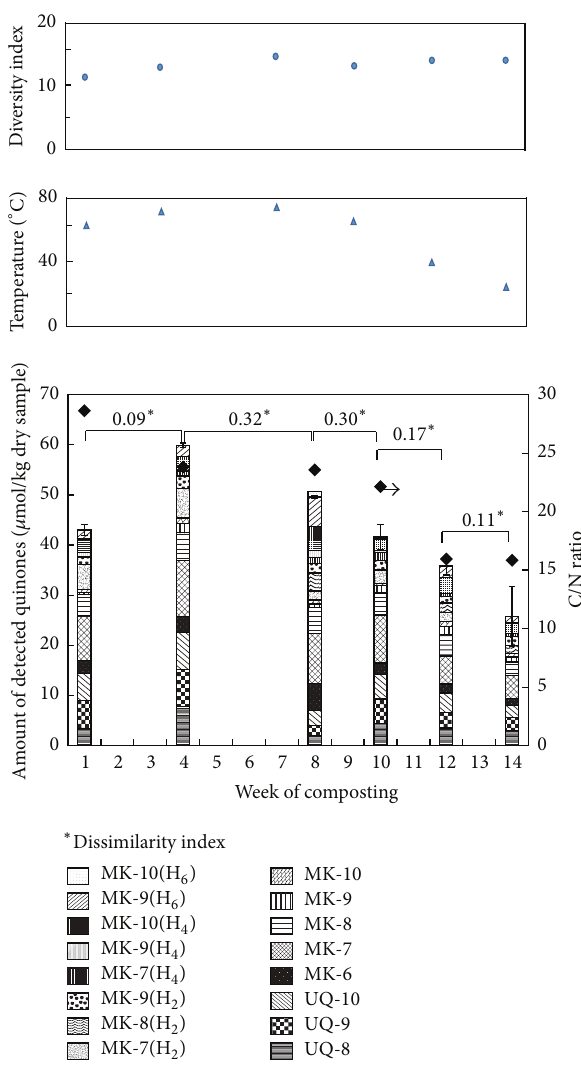
Figure 6: Changes of the quinone profile, C/N ratio, temperature, anddiversityindexofcompostfromfoodwasteandwoodchips.The number represents the dissimilarity index of the quinones profile. Number of samples examined =